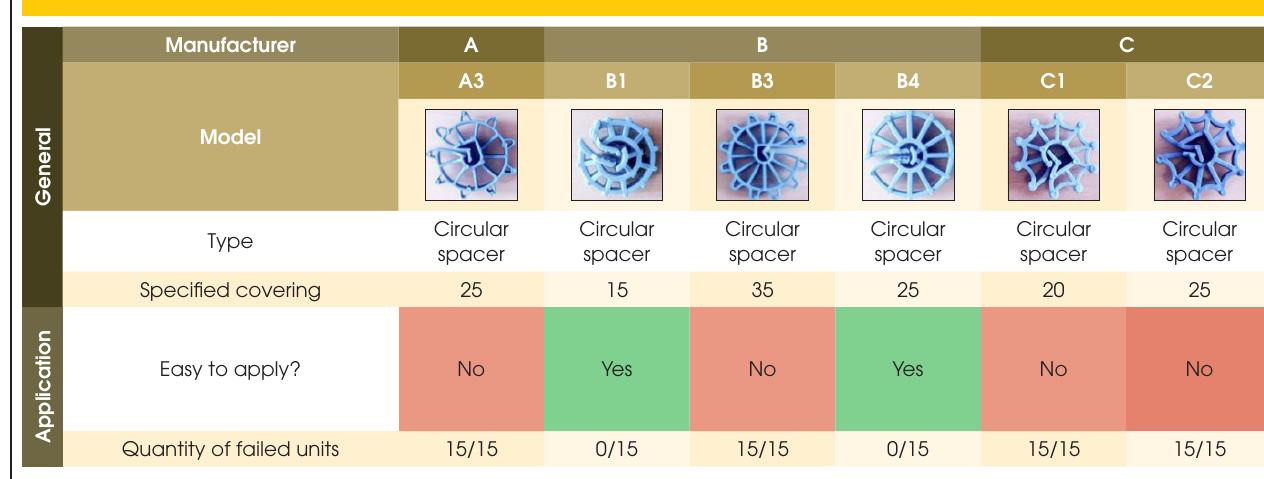
Table 25 – Results of the application requirement